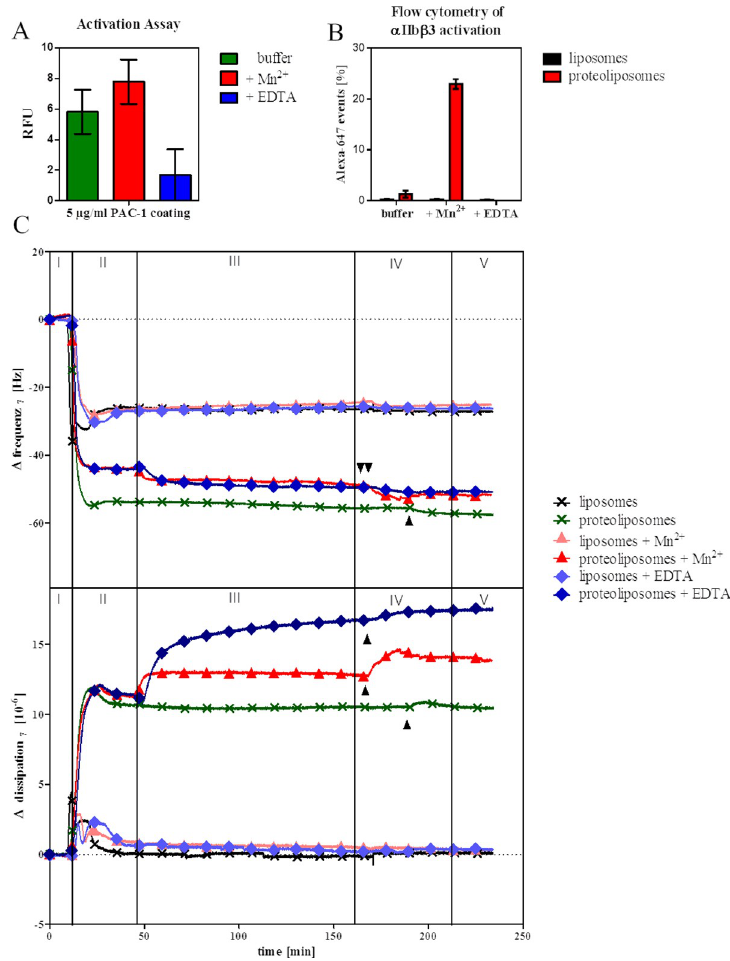
Fig 3. Activation of α IIb β 3. A) Activation assay using PAC-1 antibody. Each value is the mean of three replicate measurements ± SEM. The binding of PE CF-liposomes/proteoliposomes to 5 μ g/mL PAC-1 coated on a microtiter plate was detected after incubation with buffer (green), 1 mM Mn 2+ (red) and 5 mM EDTA (blue). Values of bare liposome samples were subtracted from proteoliposome values. The y-axis shows relative fluorescence units (RFU). B) Integrin activation investigated by flow cytometry with PE CF-liposomes (black)/proteoliposomes (red) by adding PAC-1-Alexa 647-coupled antibody. Percentages of the mean ± SEM of Alexa-647 signal of PE positive events incubated with buffer, Mn 2+ and EDTA are shown. C) Representative QCM-D data showing the changes in frequency f (top) and dissipation D (bottom) of the seventh overtone for the binding of the conformation-specific antibody PAC- 1 at 37˚C. Buffer was injected over the SiO 2 sensors (phase I) and after reaching a baseline liposomes or proteoliposomes were injected and the formation of a bilayer was observed (phase II). After a washing step with either liposome buffer, liposome buffer with 1 mM Mn 2+ , or 5 mM EDTA (phase III), PAC-1 antibody was injected (phase IV) and binding was observed (indicated by arrows). Rinsing with the respective buffer followed (phase